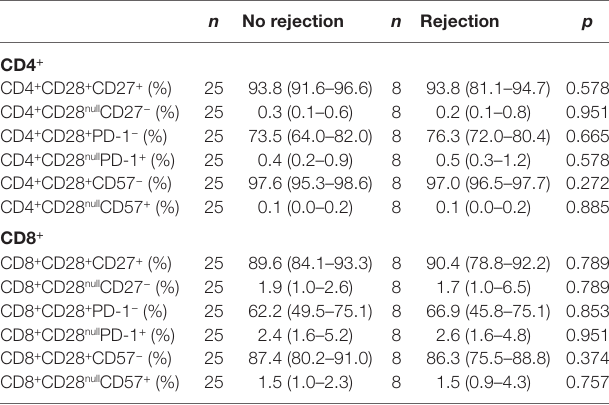
TaBle 2 | CD4 + and CD8 + T-cell differentiation status in lymph node with regard to the development of rejection.